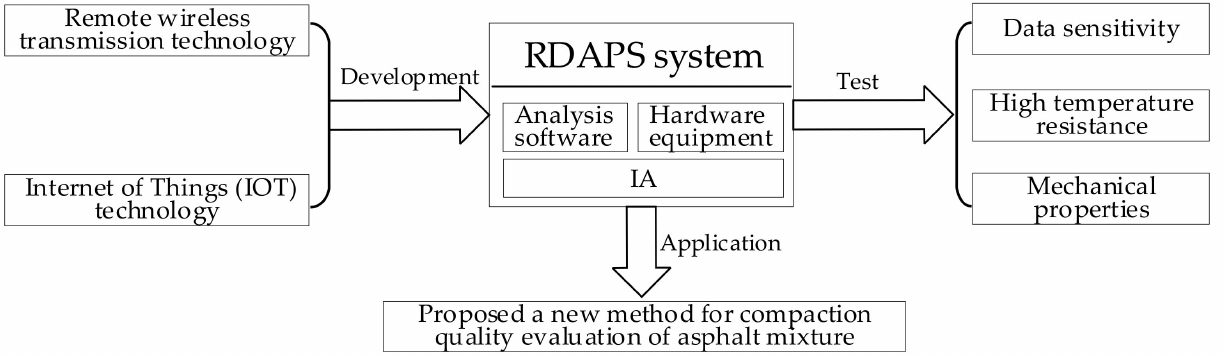
Figure 2. Research flowchart.